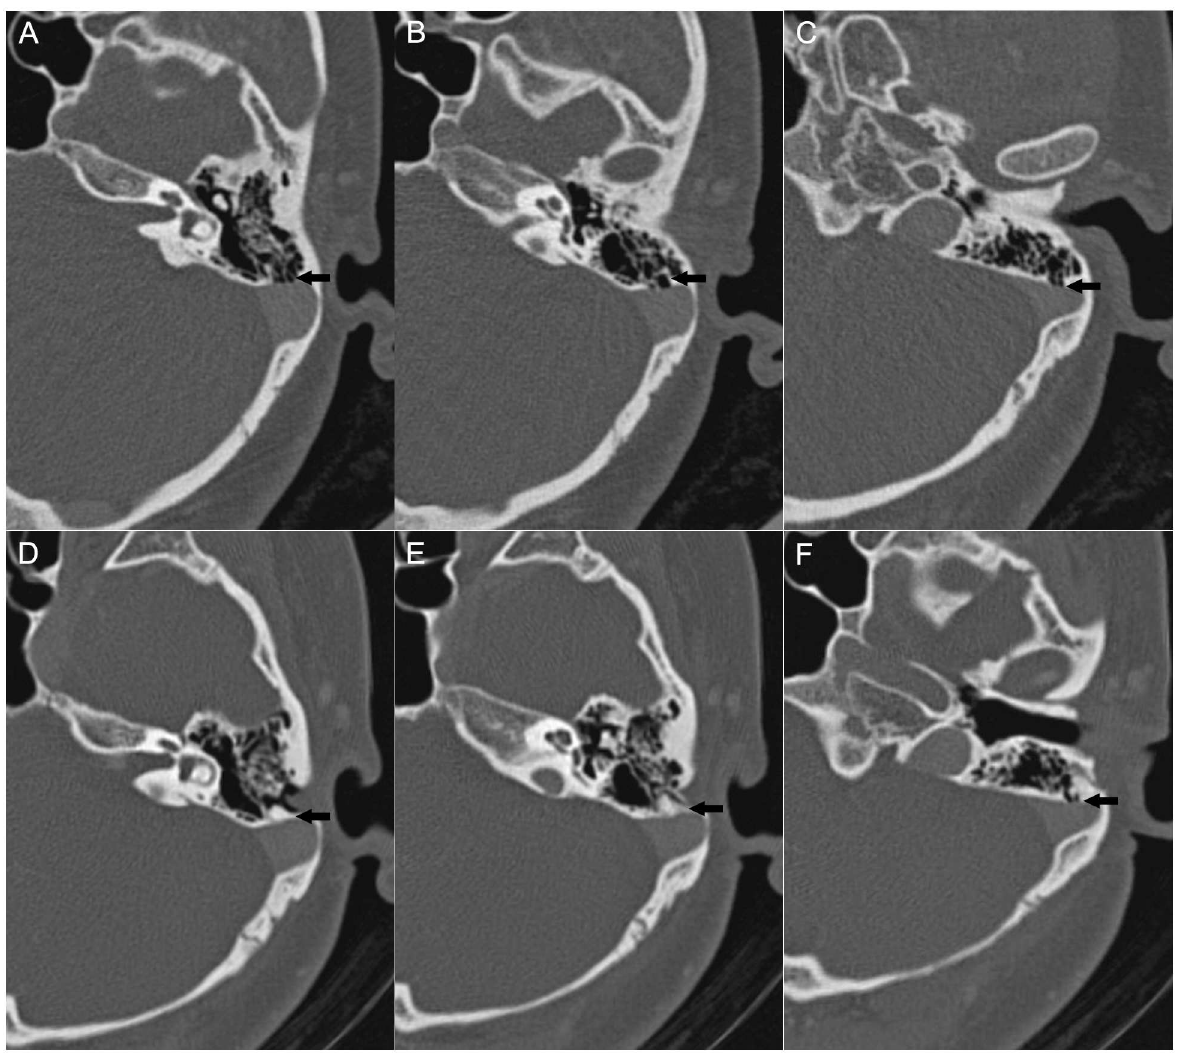
Fig 4. Preoperative (A–C) and postoperative (D–F) CTA images of a patient (Patient 9) with partial resolution of PT following surgery. The layers in (A), (B) and (C) correspondto those in (D), (E) and (F), respectively. The dehiscences in layers (A) and (B) are repairedpostoperatively as shown in (D) and (E); whereas the dehiscence in layer (C) is not repairedas shown in